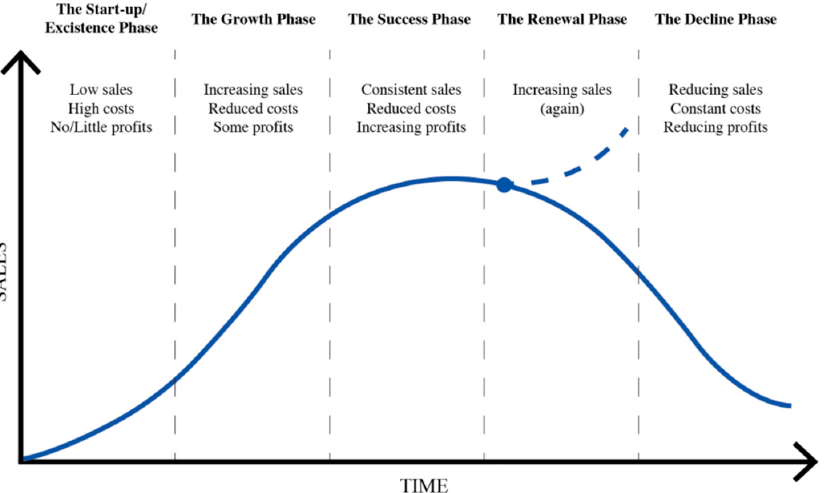
Figure 2. The five sequential stages of an organizational life cycle (Lester et al. 2003) adapted from (Wynn 2003).